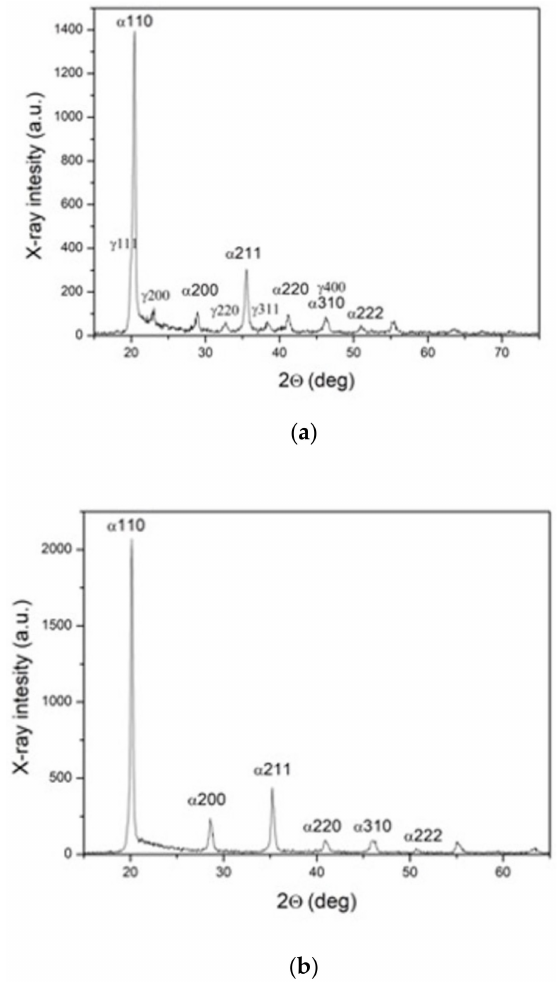
Figure 6. XRD spectra of selected heat-treated specimens: ( a ) specimen PT- γ -2 and ( b ) specimen PT- γ -3.